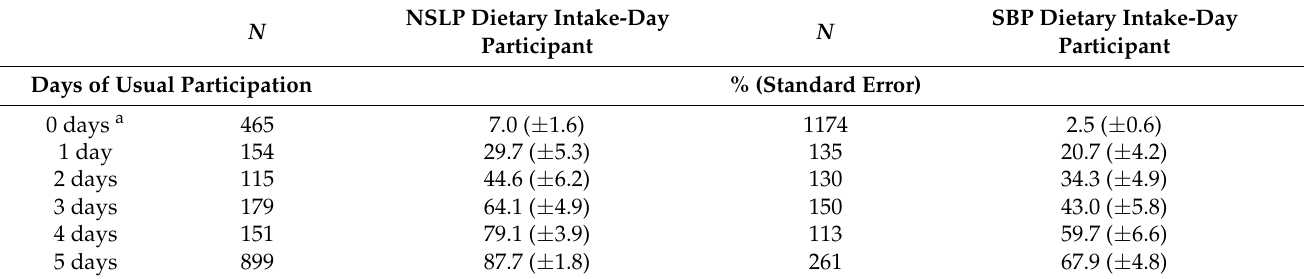
Table A1. Proportion of dietary intake-day participants by usual days of participation in the NSLP and SBP.